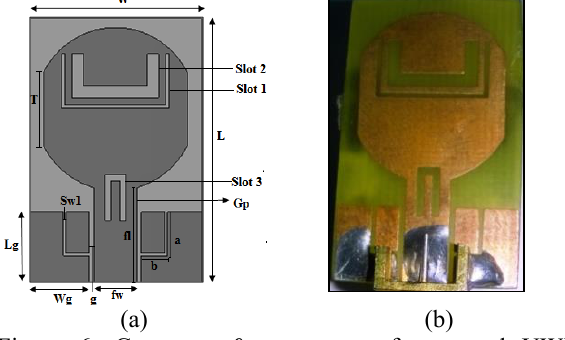
Figure 6: Geometry & prototype of proposed UWB antenna with triple band notched